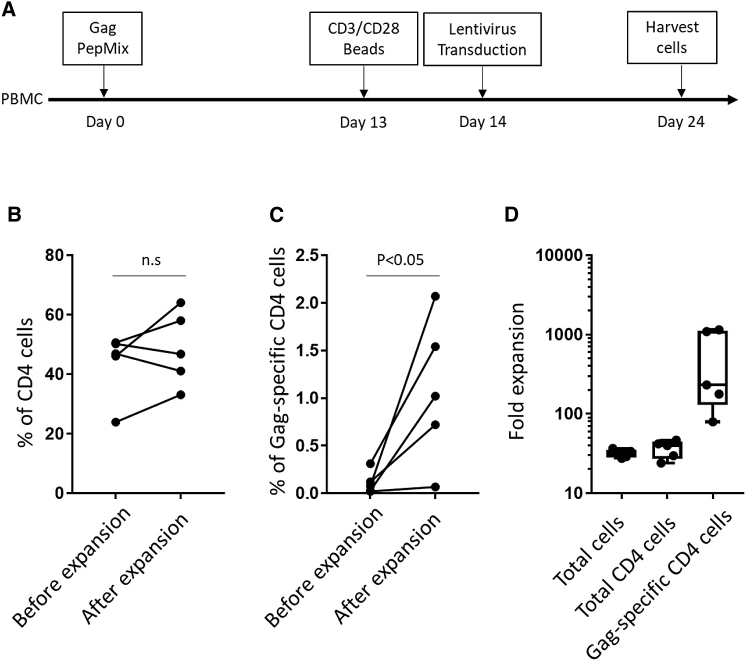
Expansion of HIV Gag-Specific CD4 T Cells by Antigen-Specific Enrichment and Nonspecific Stimulation(A) Experimental design to expand HIV Gag-specific T cells. (B and C) The percentage of CD4 (B) and Gag-specific CD4 T cells (C) before and after expansion. Paired T Tests were performed. All tests were two-tailed and P values of P<0.05 were considered significant. (D) Fold expansion of total cells, total CD4 T cells, and HIV Gag-specific CD4 T cells. Boxplots show all points (minimum [min] to maximum [max]) and mean.